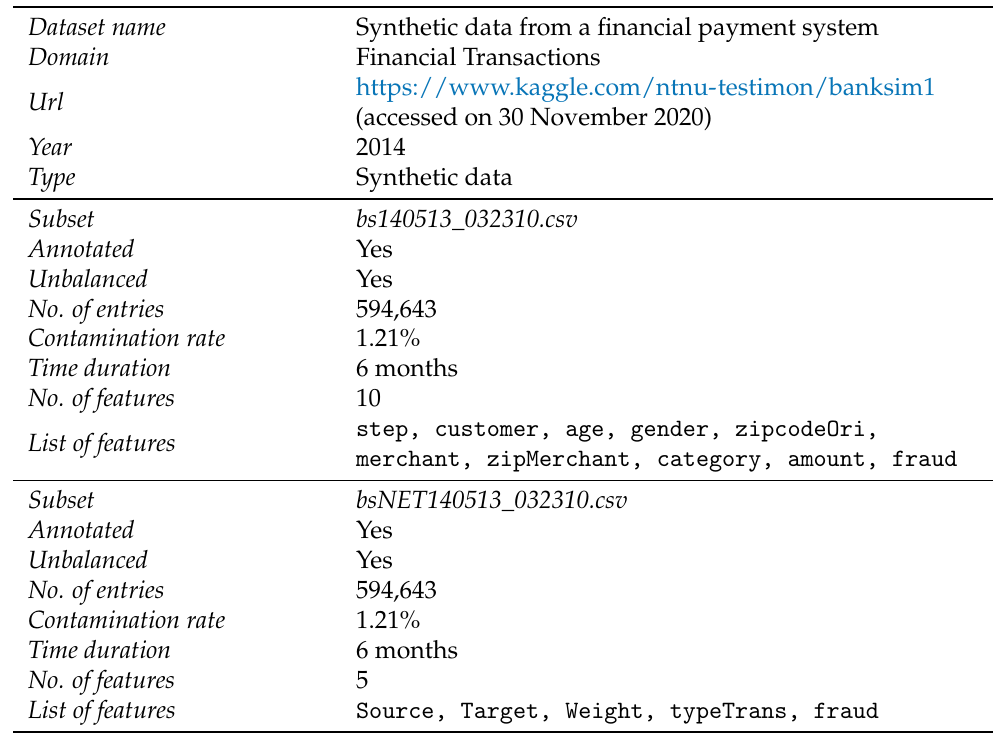
Table 6. Synthetic data from a financial payment system dataset overview.